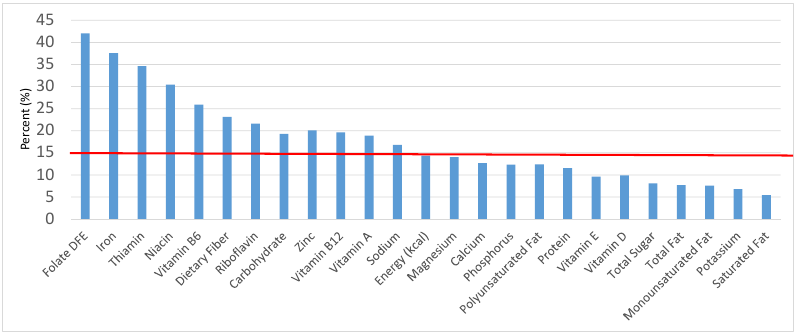
Figure 3. Grain foods sources of energy and nutrients for children 4–8 years old ( N = 1917, daily intake data): DFE = Dietary Folate Equivalents; solid red line represents percentage of energy (kcal) provided in the diet relative to nutrients—nutrients above the red line show the grain food’s contribution to nutrient density.